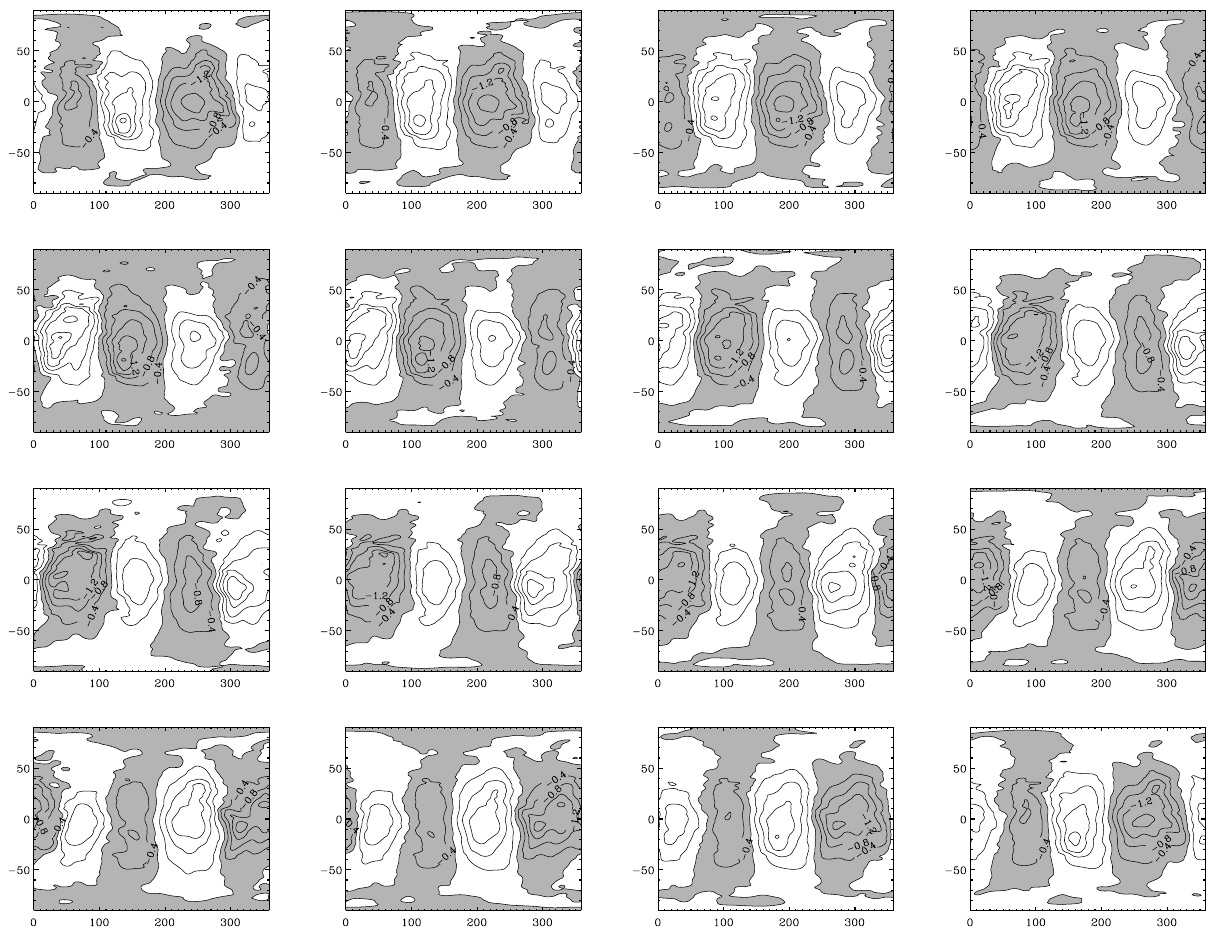
Fig. 4. Interpolated climatological daily cycle at 1.5h intervals. Time marches horizontally from the top left corner (00:00UT) to the bottom right corner (22:30UT). Table 1. S 2 rms differences ( µ b) with station estimates